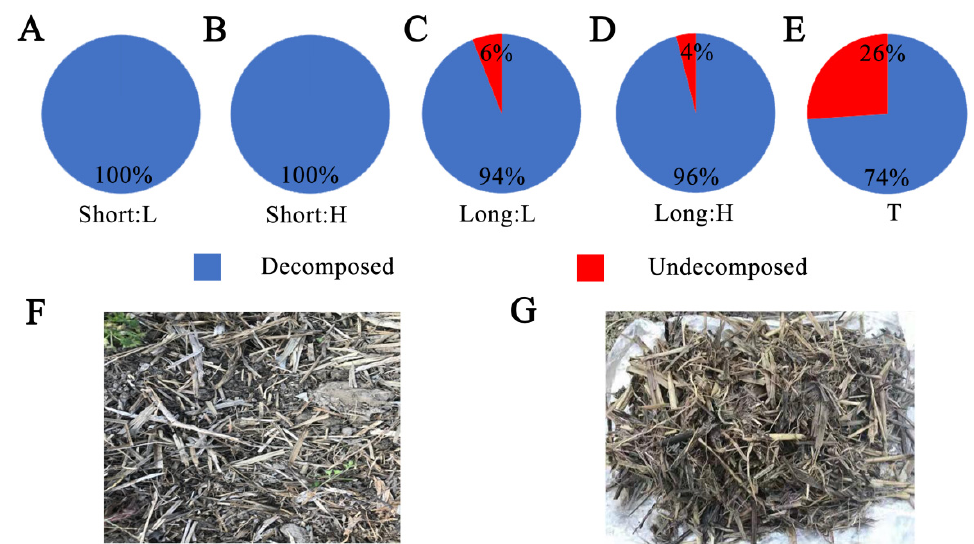
Figure 3. Decomposition of straw in the field. ( A – E ) Straw decomposition rates of different mulching treatments. Short: 10 cm wheat straw by mechanical cutting. Long: wheat straw without any treatment. L and H: wheat straw mulching treatments (e.g., L, 11,250 kg/ha and H, 18,750 kg/ha). T: rice straw mulching treatment (T, 15,000 kg/ha). ( F ) Remaining straw after harvest; ( G ) Collected remaining straw for assay.